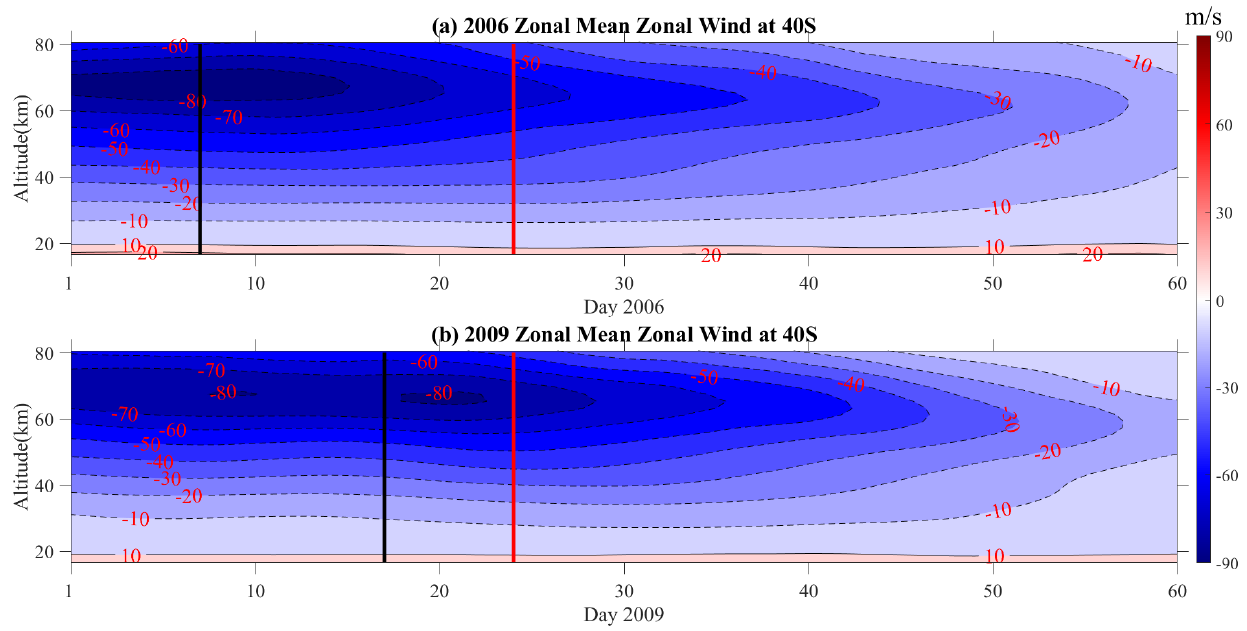
Figure 8. Temporal and altitude variations of the zonal mean zonal wind at 40° S in ( a ) 2006 and ( b ) 2009. The vertical black and red lines indicate the starting of the sudden stratospheric warming and the warming peak of the sudden stratospheric warming.